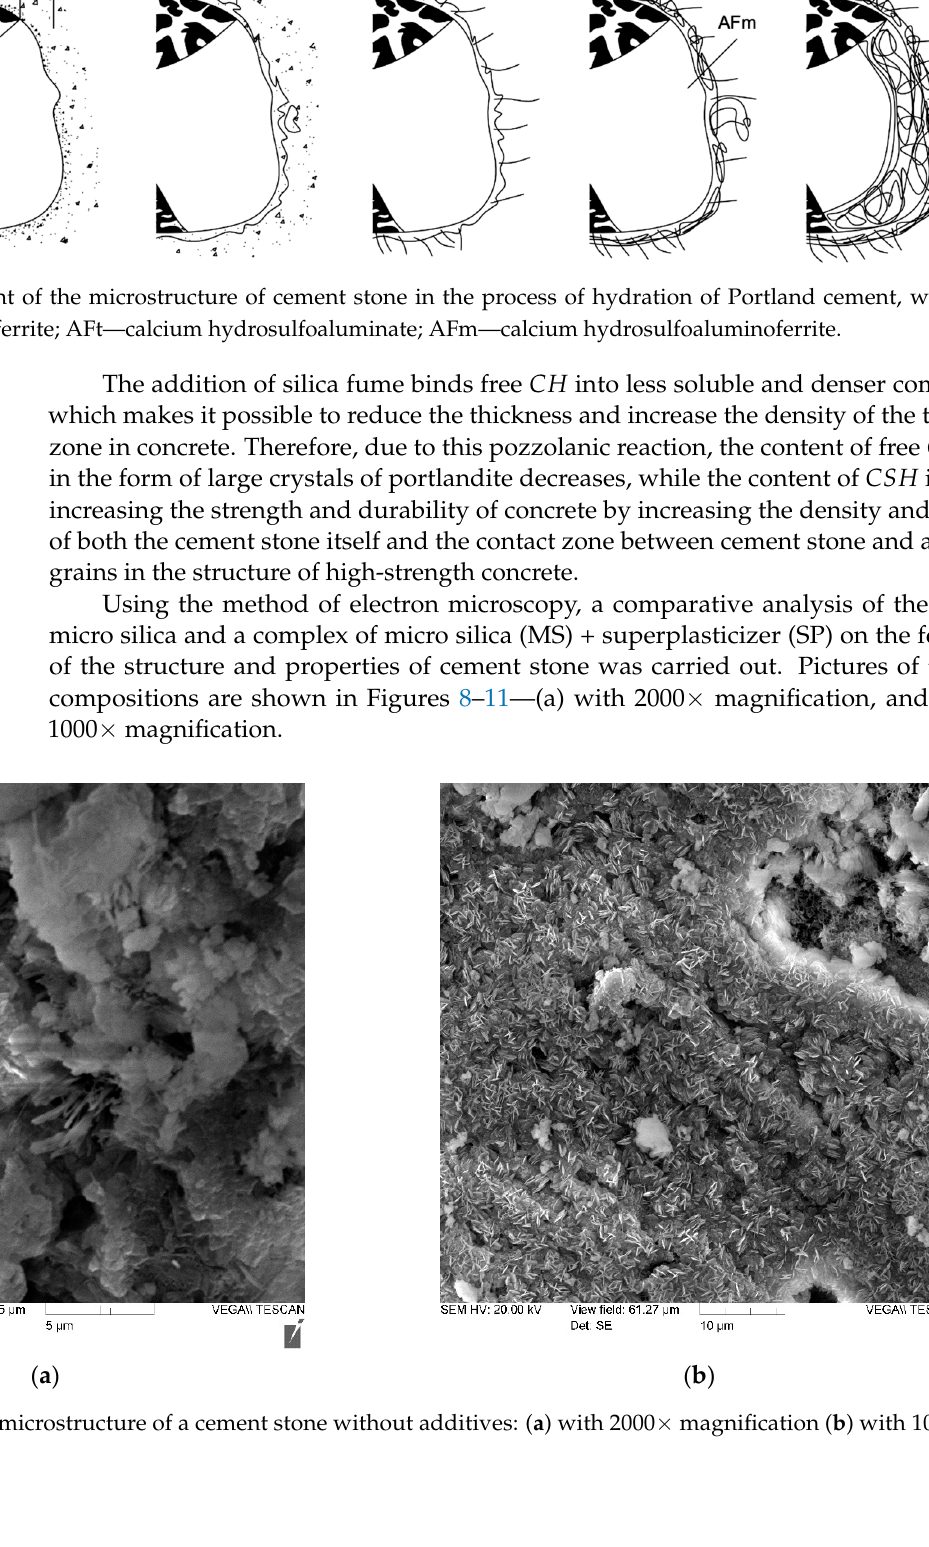
( b ) Figure 9. Photo of the microstructure of a cement stone with an MS-85 additive in an amount of 6%: ( a ) with 2000× mag- nification ( b ) with 1000× magnification.